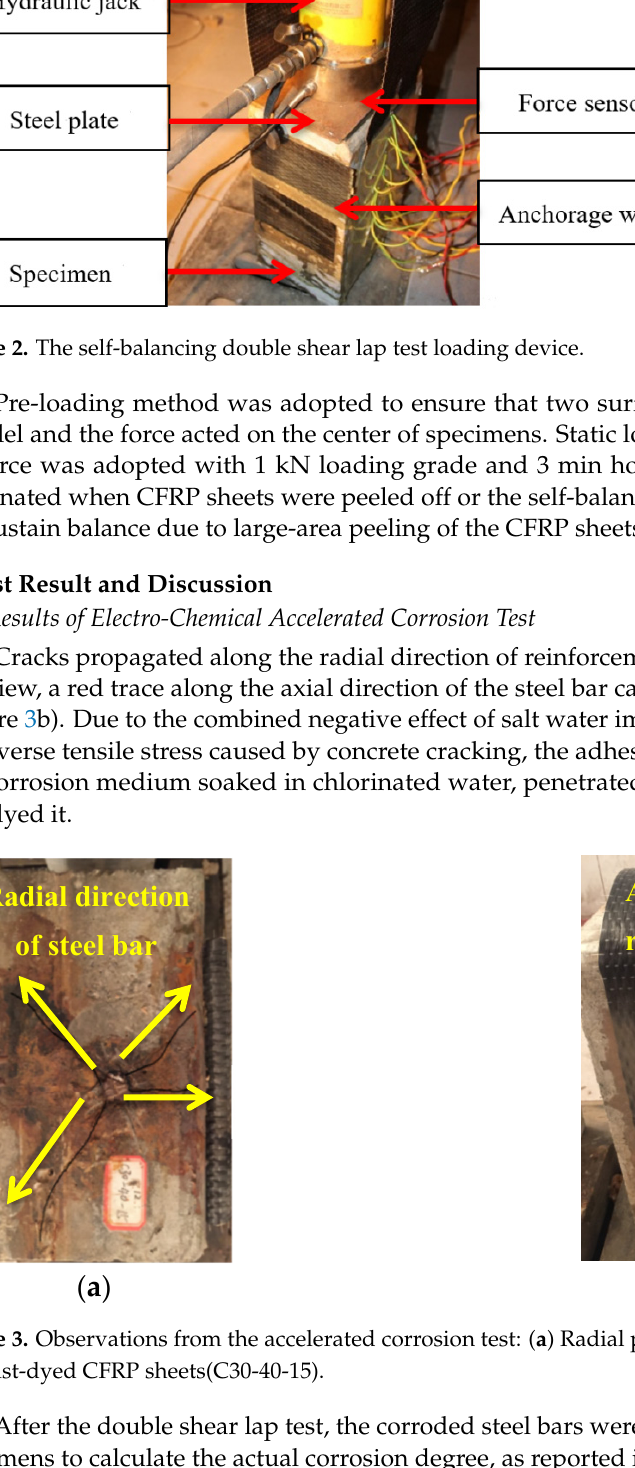
Figure 2. The self-balancing double shear lap test loading device.